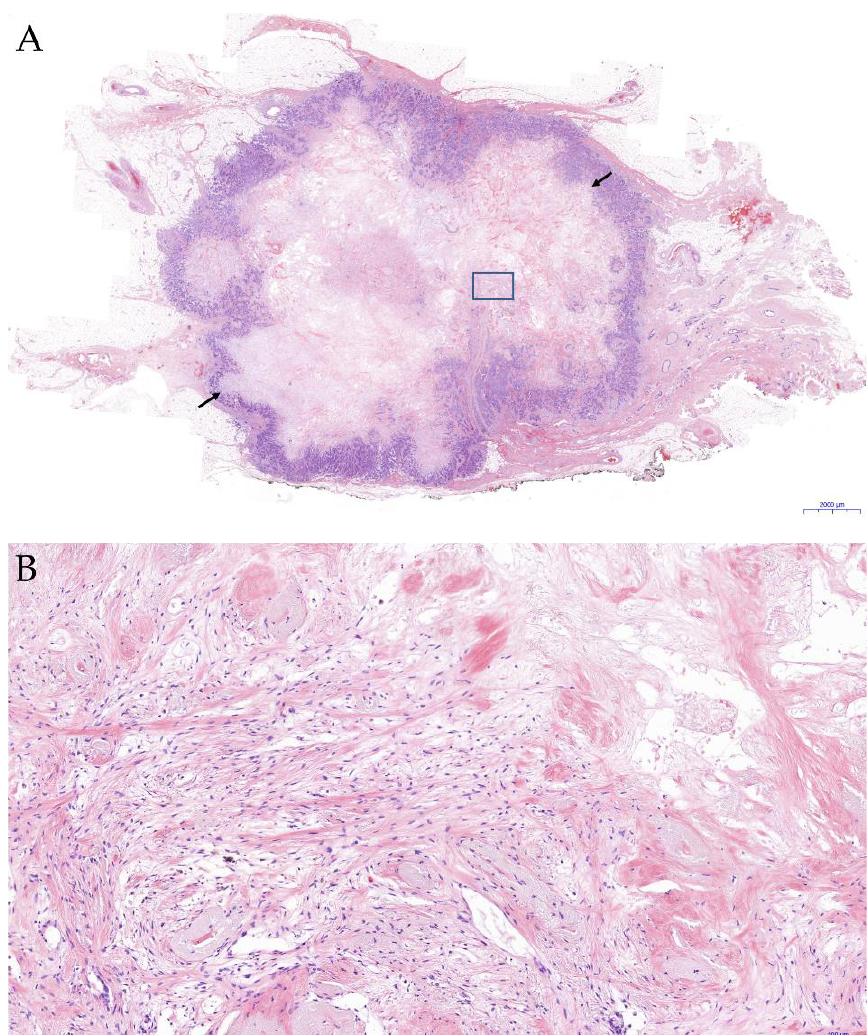
Figure 1. Representative histology of fibrotic focus (FF) in breast cancer. ( A ) Arrows indicate area of FF in invasive breast cancer tissues (H&E; magnification, ×6). The rectangle indicate the magnified area of FF shown in ( B ). ( B ) A mixture of fibroblast-like spindle cells and variable collagen fibers at the center of FF. (H&E; magnification, ×100).